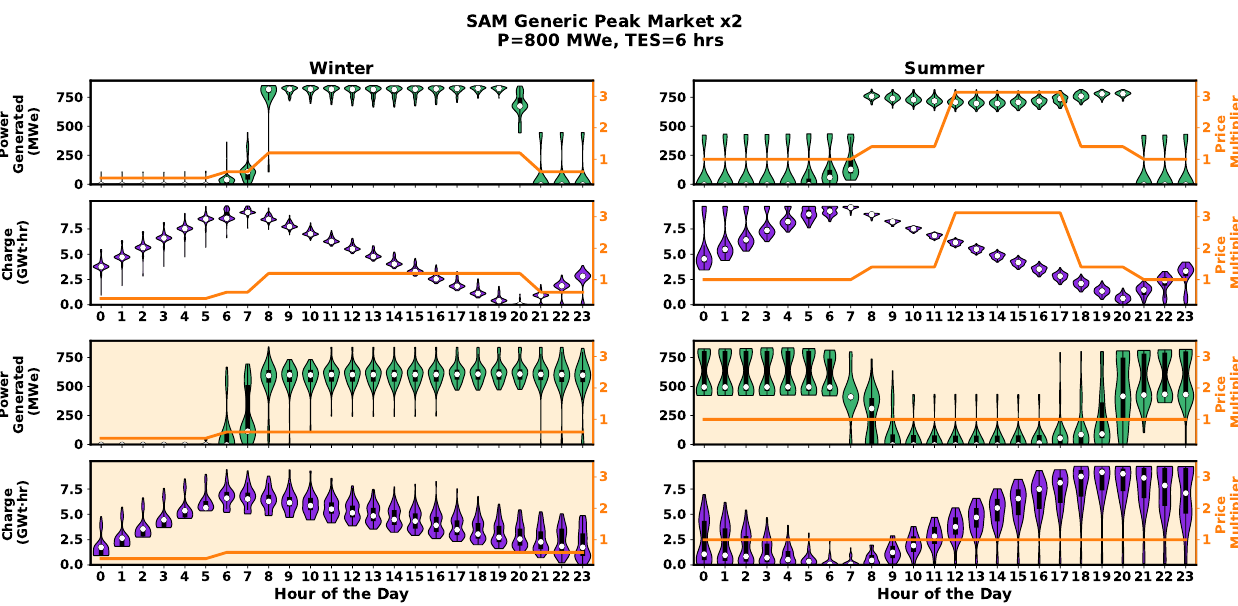
Figure 7. Hourly violin plot distributions for a year of simulated electric power and stored energy levels. Computed for an 800 MW e turbine with 6 h of TES under twice-amplified SAM generic peak market prices. Median value for each hour is shown as a white circle and the black vertical rectangle demarcates 25th and 75th percentiles. Distributions are split between winter and summer price schedules as well as weekday and weekend prices; price multipliers are shown on the right